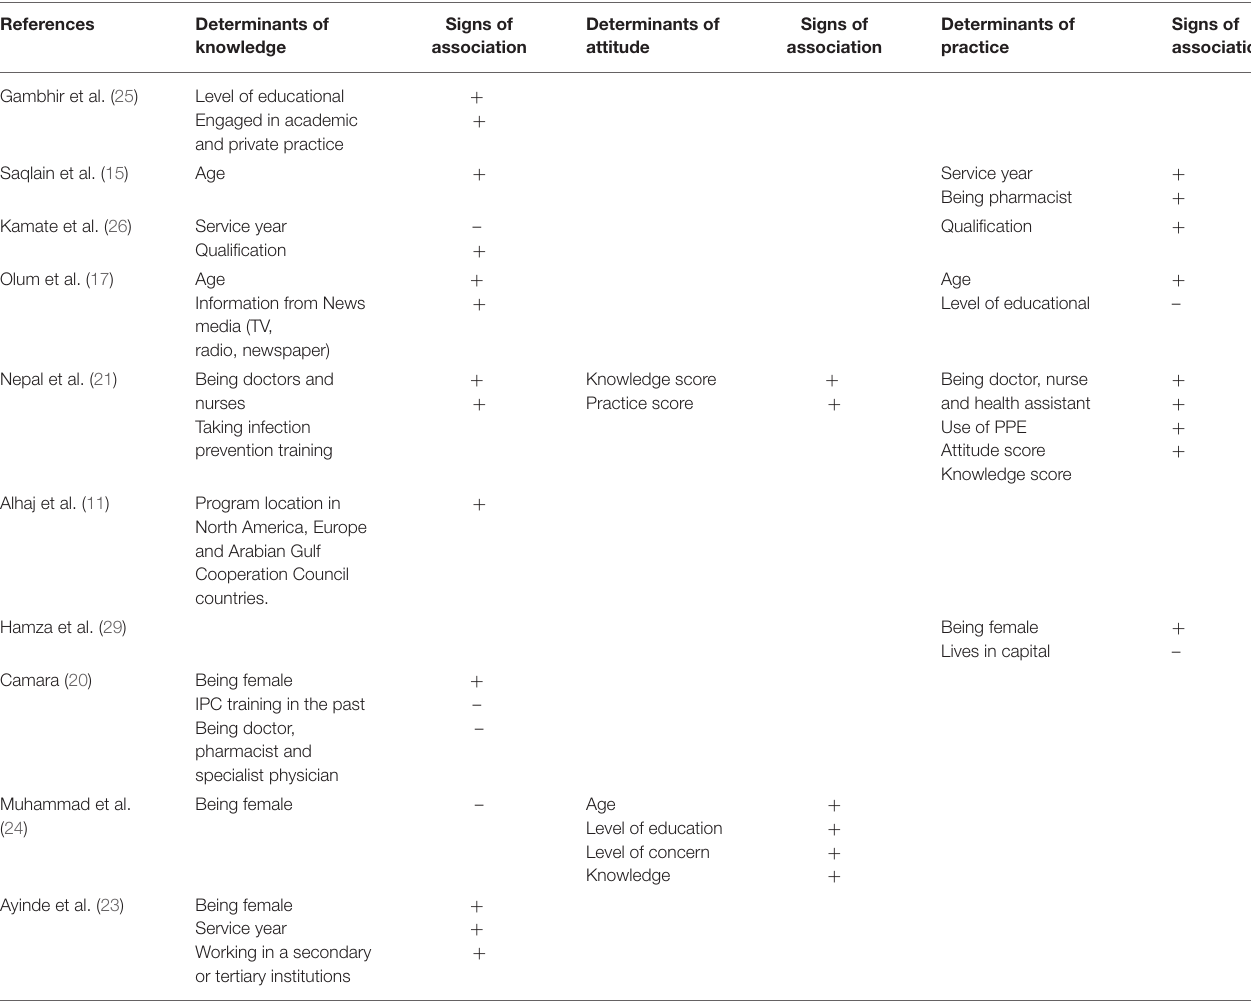
TABLE 3 | Factors associated with healthcare providers’ knowledge, attitude, and practice toward